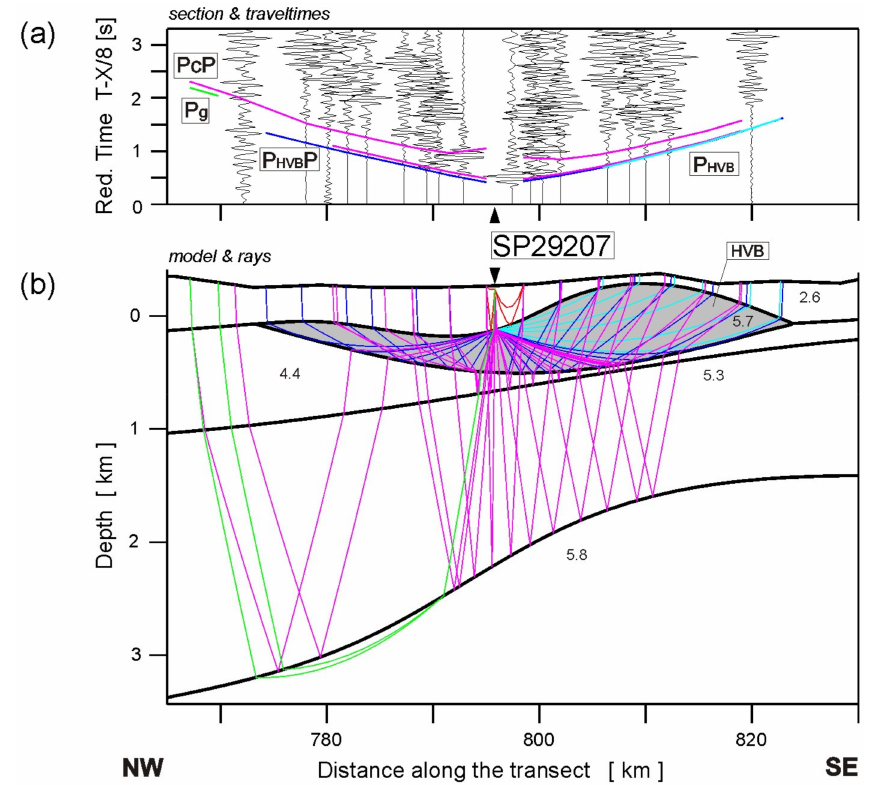
Figure 9. Example of seismic modelling of the high-velocity body (HVB) in the upper crust near SP29207, along the TTZ-South profile. ( a ) Seismic record section of P-waves with theoretical travel- times for the corresponding model (Figure 7) calculated using the SEIS83 ray-tracing package [106]. The seismograms show the trace-normalized, vertical-component of ground motion band-pass filtered from 2–15 Hz. Reduction velocity is 8.0 km/s. ( b ) Ray diagram of selected rays using the SEIS83 package. Abbreviations of seismic phases as in Figure 5 and P HVB and P HVB P—refraction through and reflection from the base of the high-velocity body,